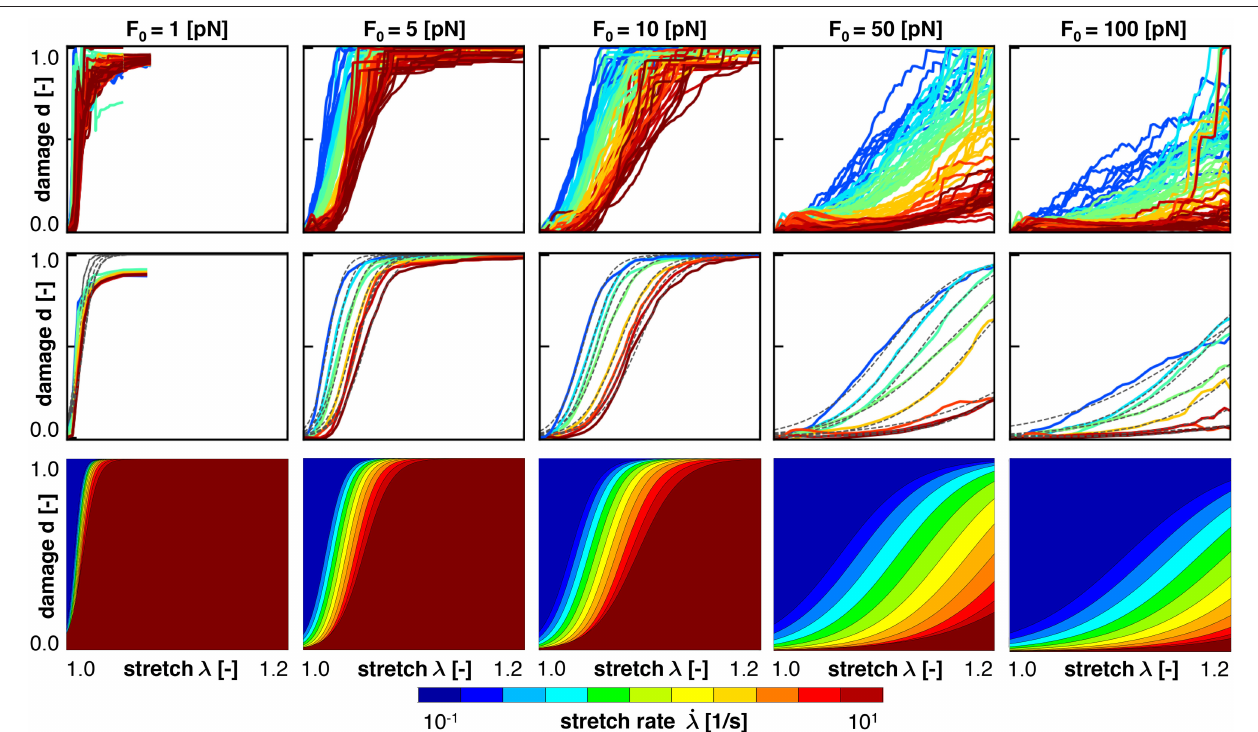
FIGURE 6 | Axonal damage vs. axonal stretch color coded by the stretch rate for five bond strengths. Discrete axonal damage simulations with n = 10 simulations for each stretch rate (Top) ; homogenization using the average response for each stretch rate to identify the parameters for S-shaped curve of the homogenized damage model (Middle) ; and continuum axonal damage simulation (Bottom) . The graphs demonstrate an important feature of the Bell model: at higher stretch rates, axonal damage occurs at higher axonal stretch.